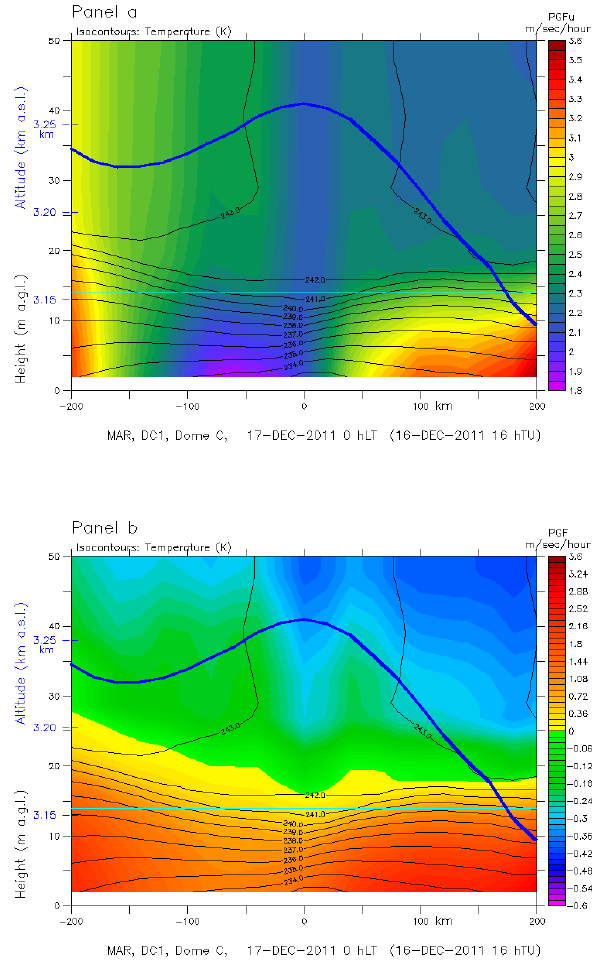
Figure 8. (a) Temperature and PGF u at midnight, along the x axis. Distance is from Dome C. (b) Temperature and PGF, at midnight, along the x axis. Distance is from Dome